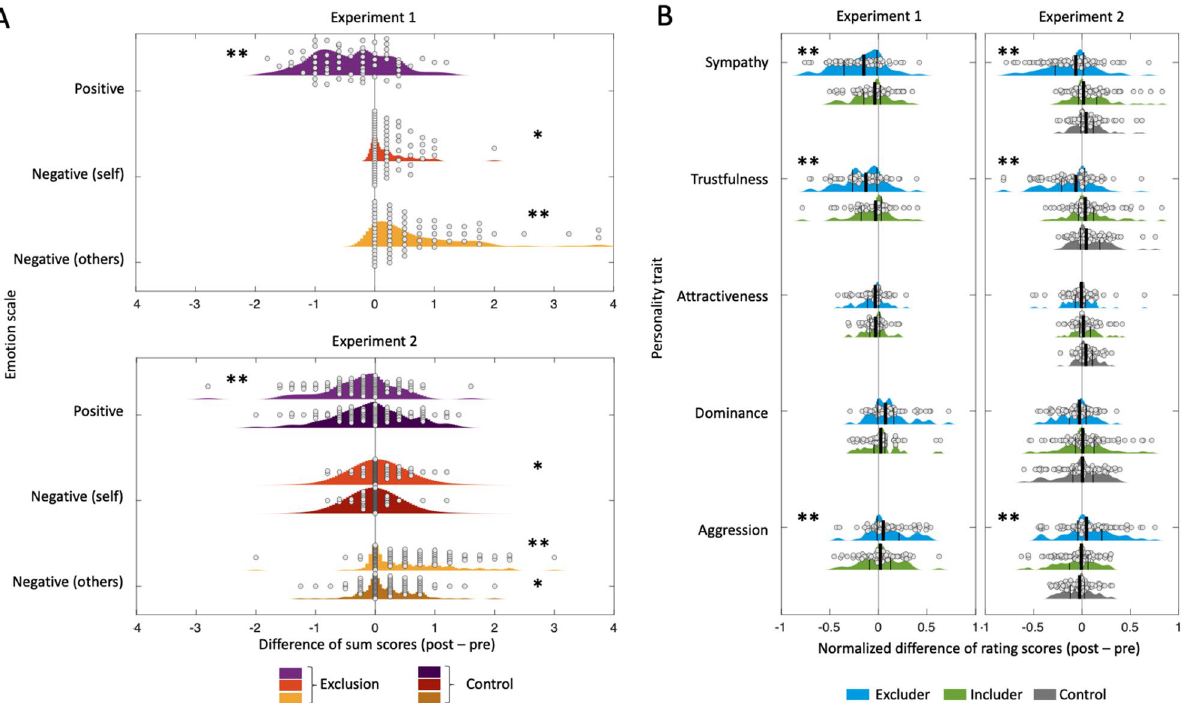
Figure 4. Emotional reactions and ratings of other players. Displayed are individual values (circles) and associated probability densities for ( A ) Emotions threat through social exclusion: post–pre gaming differences in emotional sub scale sum scores for experiment 1 (upper three rows) and experiment 2 (lower six rows). Results from control condition for experiment 2 are displayed in darkened colors. ( B ) The effect of social exclusion on personality trait ratings. Results for control condition in experiment 2 are displayed in gray. Additionally, the median (thick black line) as well as the 25 and 75% percentiles (thin black lines) are shown. Asterisks represent significant differences between pre and post ratings/sum scores. * p < 0.05; ** p <